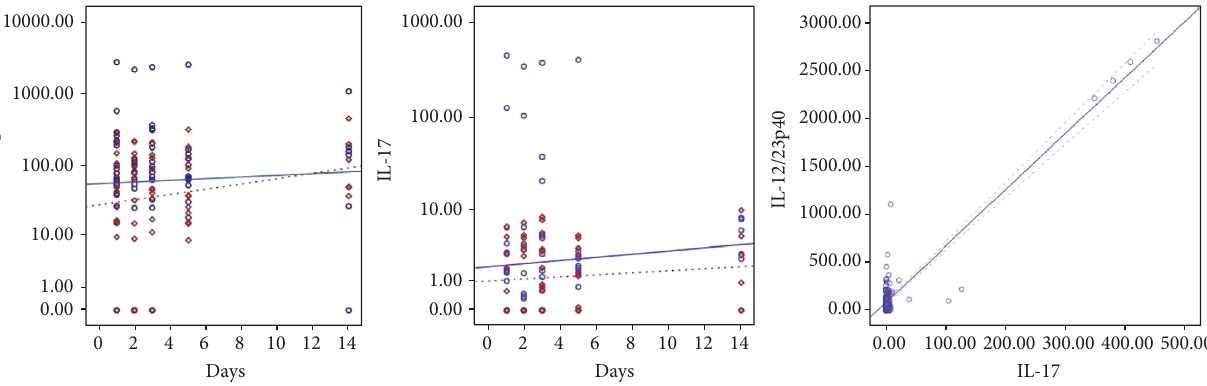
Figure 3: Fittinglinesfor sepsis(dashed lineanddiamonds)ornot(solidlineandcircles) forIL-12/23p40(right)andIL-17 (center),in base-10 log scale. On the left, the linear regression between values of IL-12/23p40 and IL-17 ( R 2 = 0 88